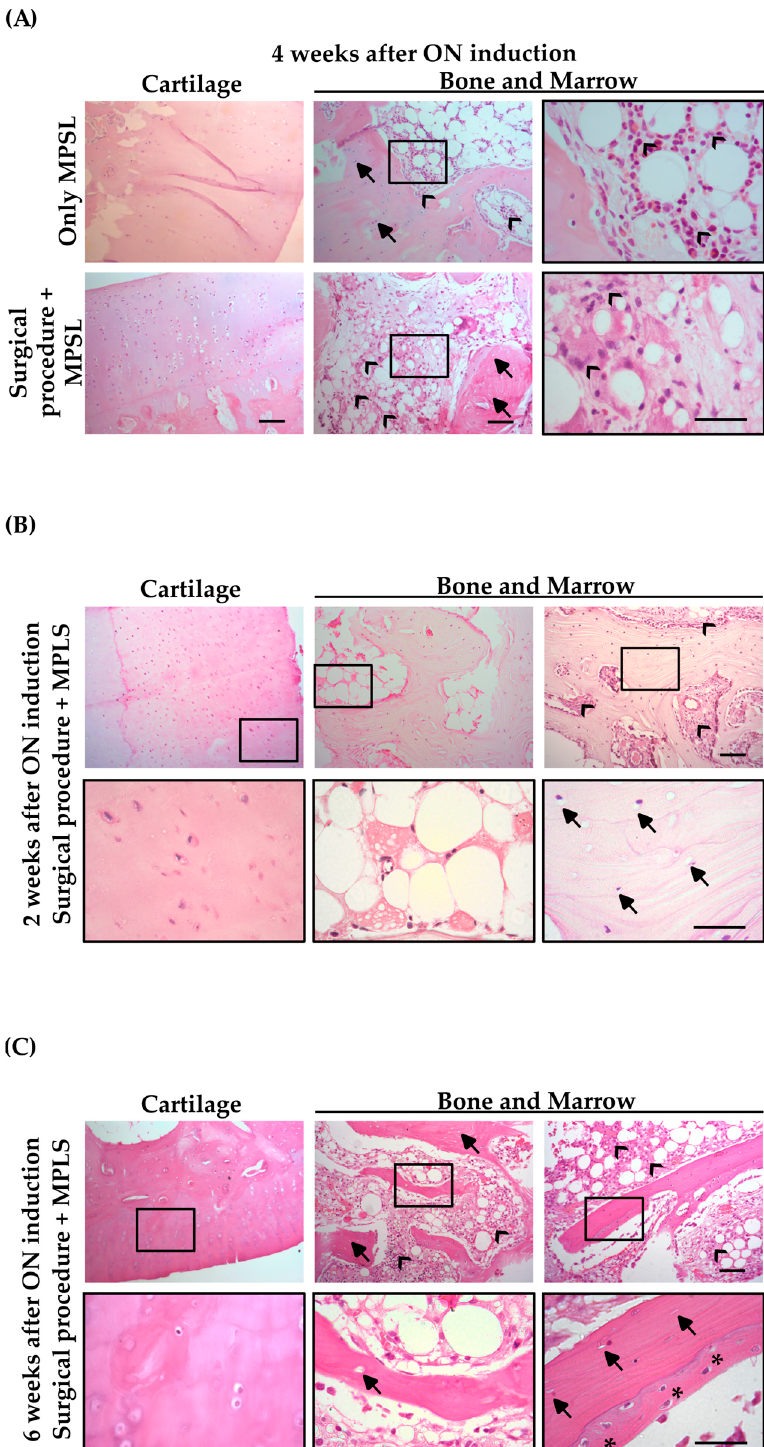
Figure 2. Histological analyses at different times after the osteonecrosis (ON) damage induction. ( A ) Comparison at 4 weeks after the ON event using only the pharmacological method with methylprednisolone (MPSL; upper panel) or the combination of the surgical procedure and MPSL (bottom panel), depicting cartilage and bone tissue. ( B ) The combination of surgical procedure and corticosteroid was also analyzed at 2 weeks and ( C ) 6 weeks after ON damage (10× and 40× magnification; scale bar 100 µm and 50 µm. Arrows: osteocyte lacunae; asterisks: spontaneous bone regeneration; arrow heads: hematopoietic cellularity).